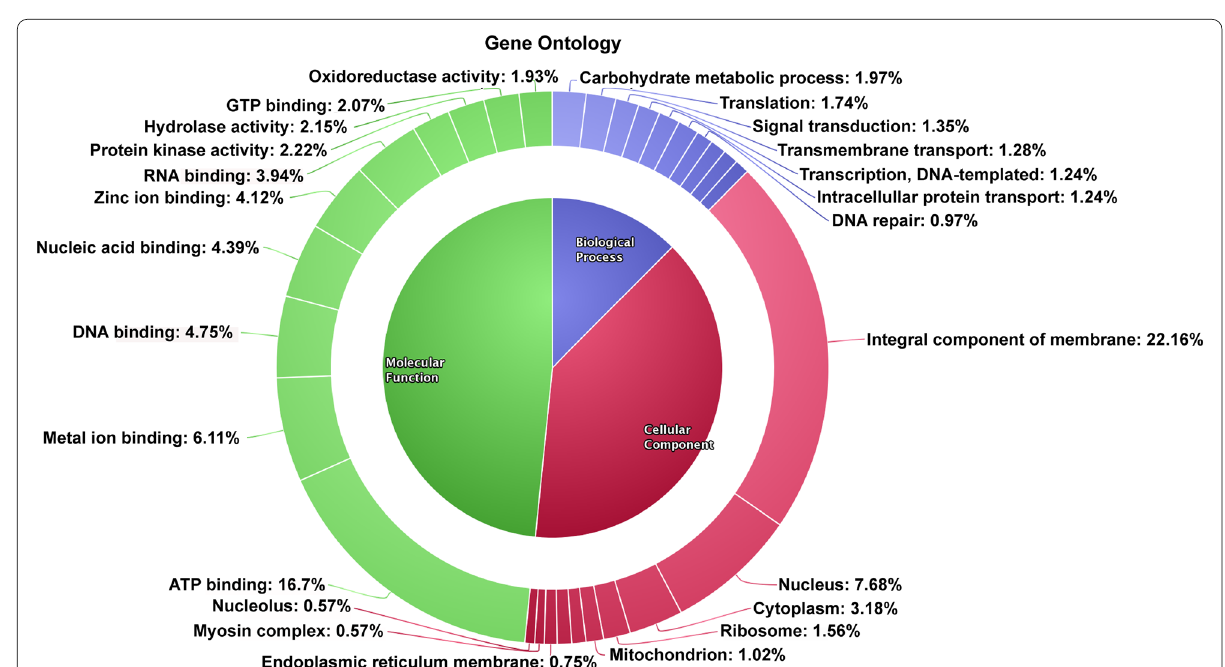
Fig. 5 Gene ontology report for G. butleri